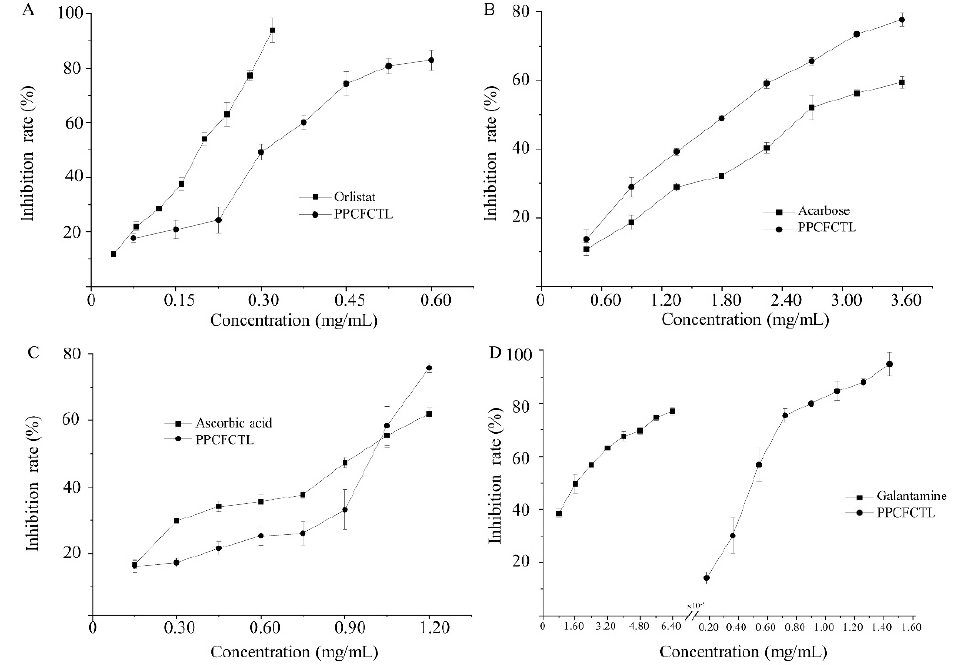
Figure 2. Enzyme inhibitory activities of PPCFCTL: ( A ) lipase inhibitory activities, ( B ) α -amylase inhibitory activities, ( C ) α -glucosidase inhibitor activities, ( D ) acetylcholinesterase inhibitory activities. Data represent means of three independent experiments (mean ± SD).